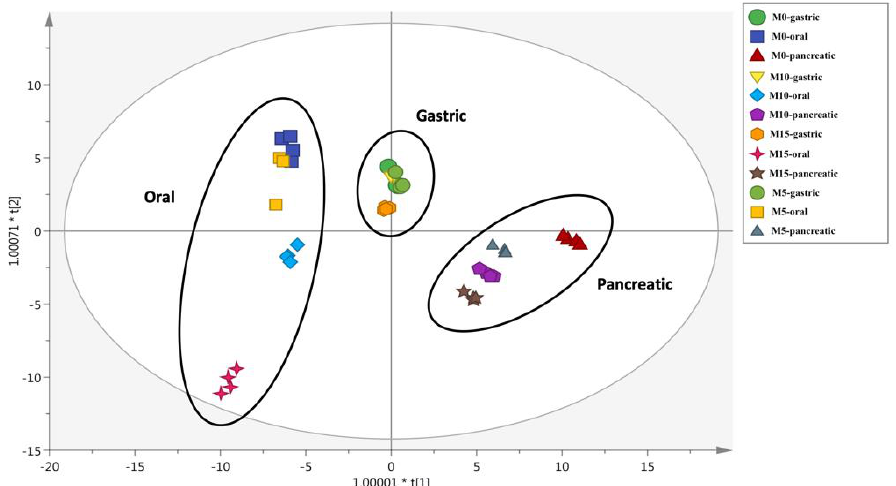
Figure 2. Orthogonal projections to latent structures discriminant analysis (OPLS-DA) score plot on the cooked pasta samples’ phenolic profile after oral, gastric, and pancreatic phases of in vitro static digestion. M0: wheat semolina fresh pasta. M5, M10, and M15: fresh pasta produced with 5, 10, and 15 g/100 g w/w MOLP, respectively.